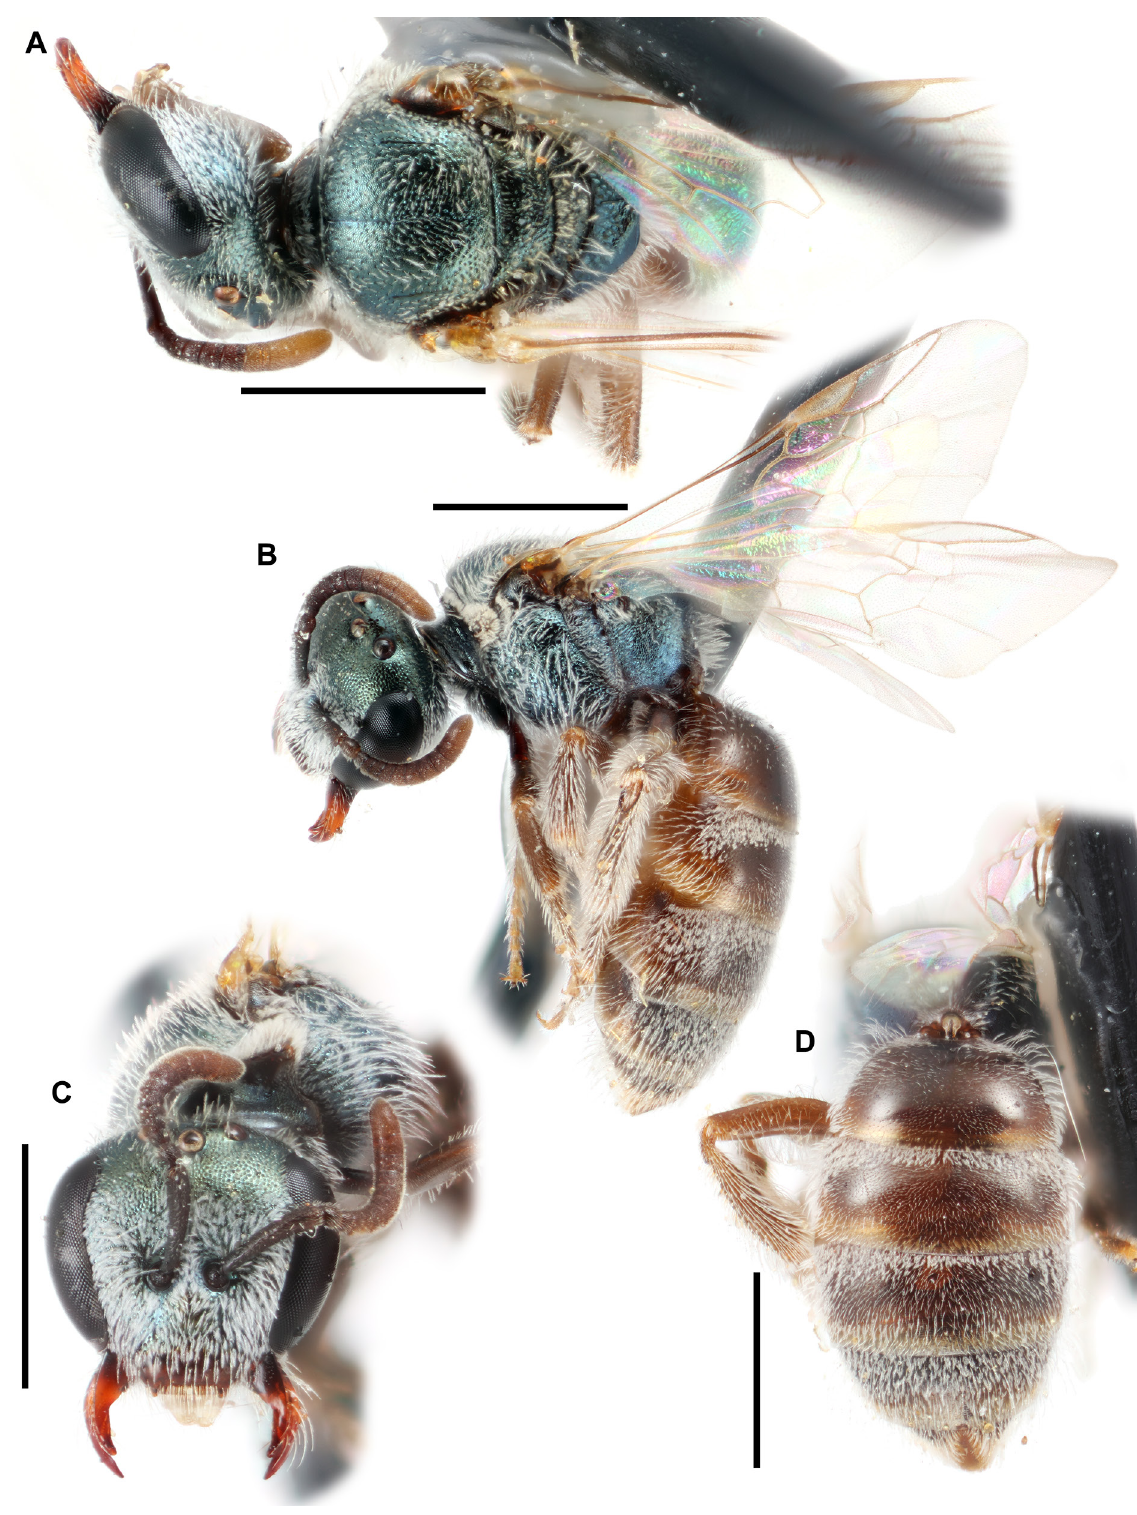
Fig. 12. Lasioglossum ( D .) deludens sp. nov., ♀, holotype (PCYU SBV047813). A . Dorsal habitus. B . Lateral habitus. C . Face. D . Metasoma. Scale bars = 1